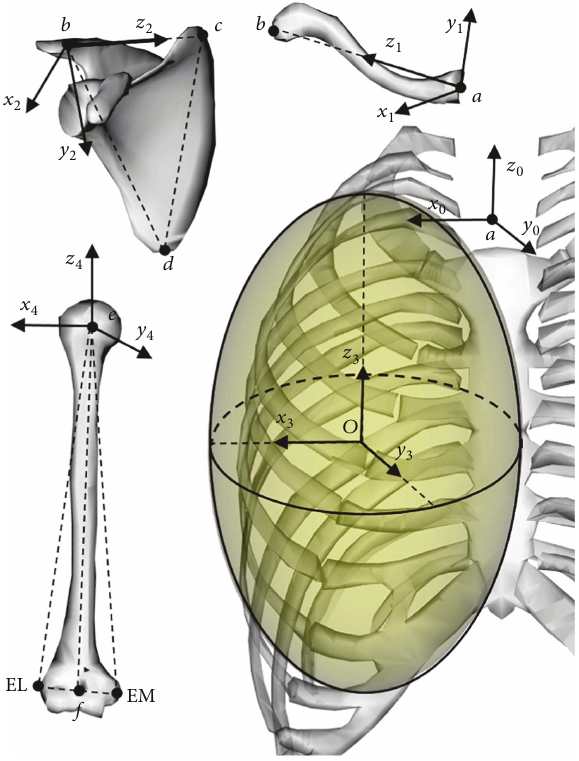
Figure 2: Shoulder bony segments and related reference